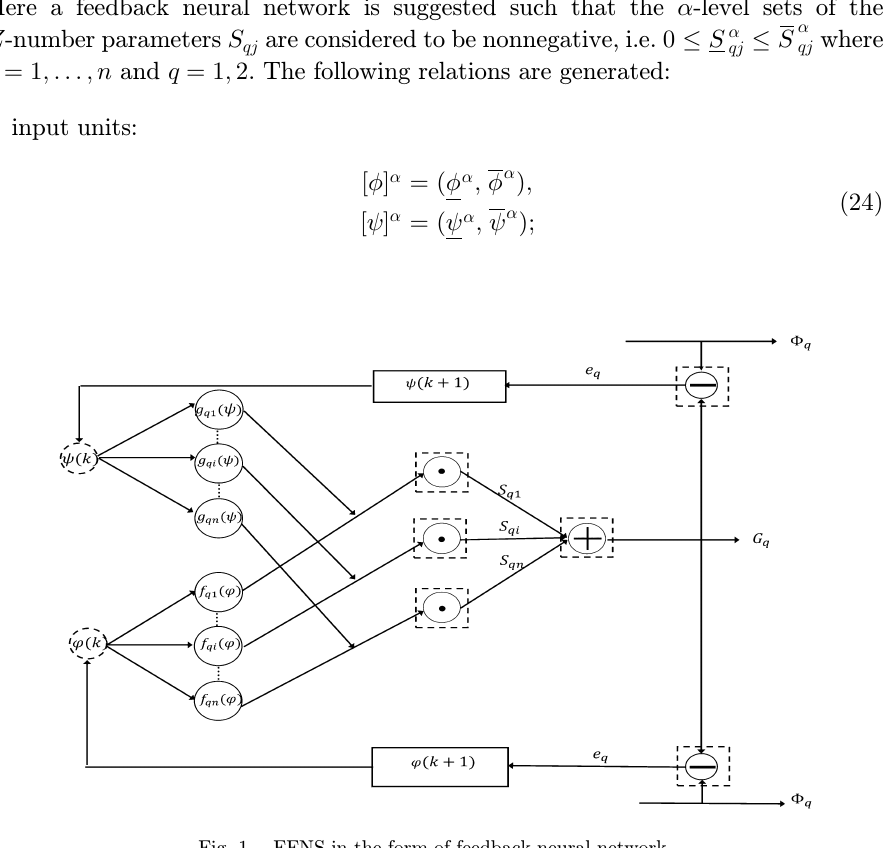
Fig. 1. FFNS in the form of feedback neural